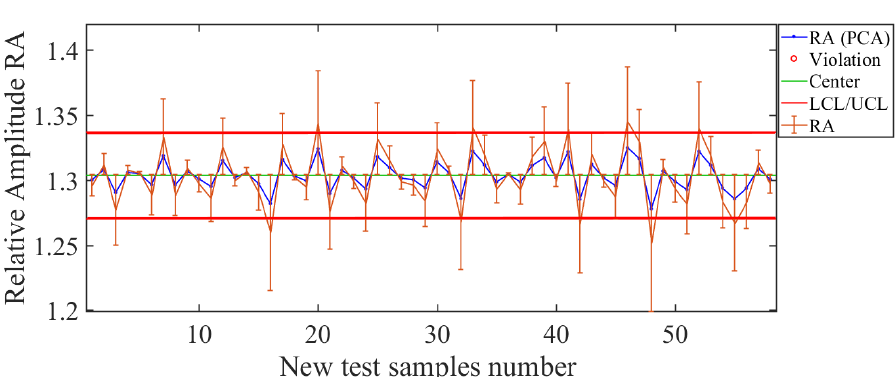
Figure 18. Soft-sensor response (control chart and error bars) for the RA descriptor. Suitable estimates are observed in the tested whole range 1.27 < RA <